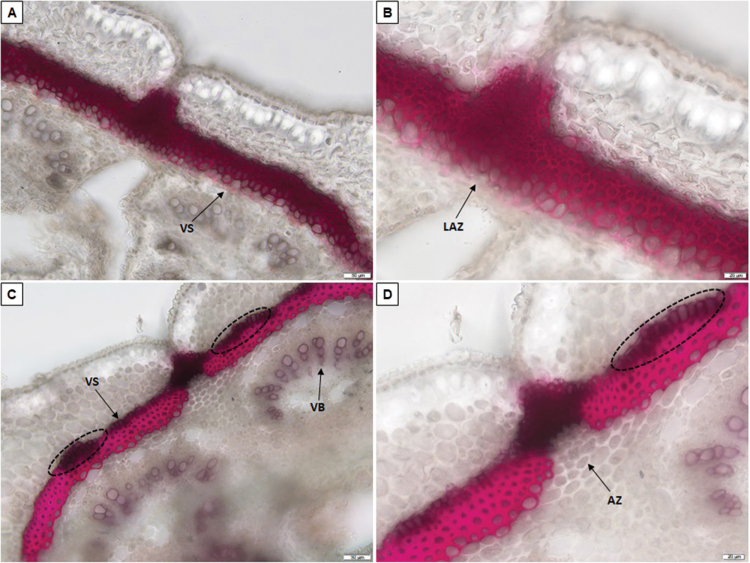
Analysis of lignification patterns of the ventral sheaths in 30-day-old pods (i.e. mature pods) of the totally indehiscent variety Midas and the highly dehiscent IL 038A/2A2. Cross-sections (section thickness, 50 µm) of the ventral suture of Midas (A, B) and 038A/2A2 (C, D) after phloroglucinol staining for lignin. (B, D) Increased magnification from (A, C). Scale bars: 50 µm (A, C); 20 µm (B, D). VS, ventral sheath; VB, vascular bundles; AZ, abscission zone; LAZ, lignified abscission zone. (C, D) Dotted ellipses, lignification areas with no strong cell wall thickening along the ventral sheath.